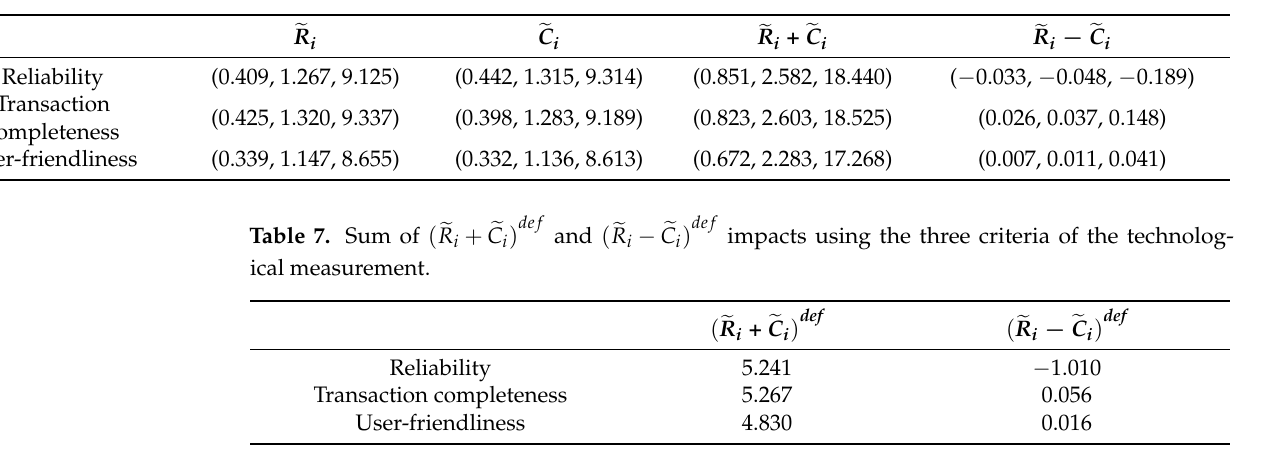
Table 6. Sum of (cid:101) R i , (cid:101) C i , (cid:101) R i + (cid:101) C i , and (cid:101) R i − (cid:101) C i impacts using the second-tier criteria of the technological measurement.